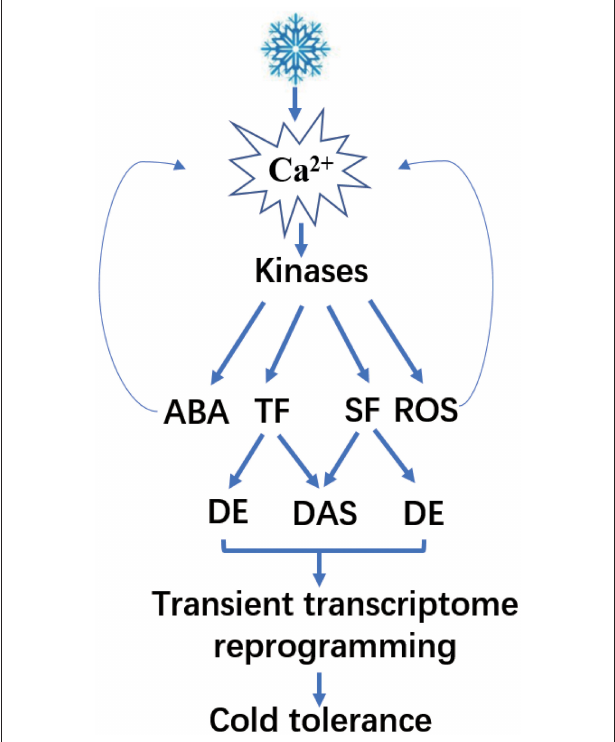
FIGURE 13 | A model for the cold-signaling pathway and gene regulation in poplar.